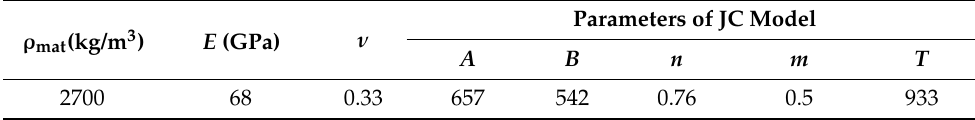
Table 2. Parameter used in Taylor impact finite element model.